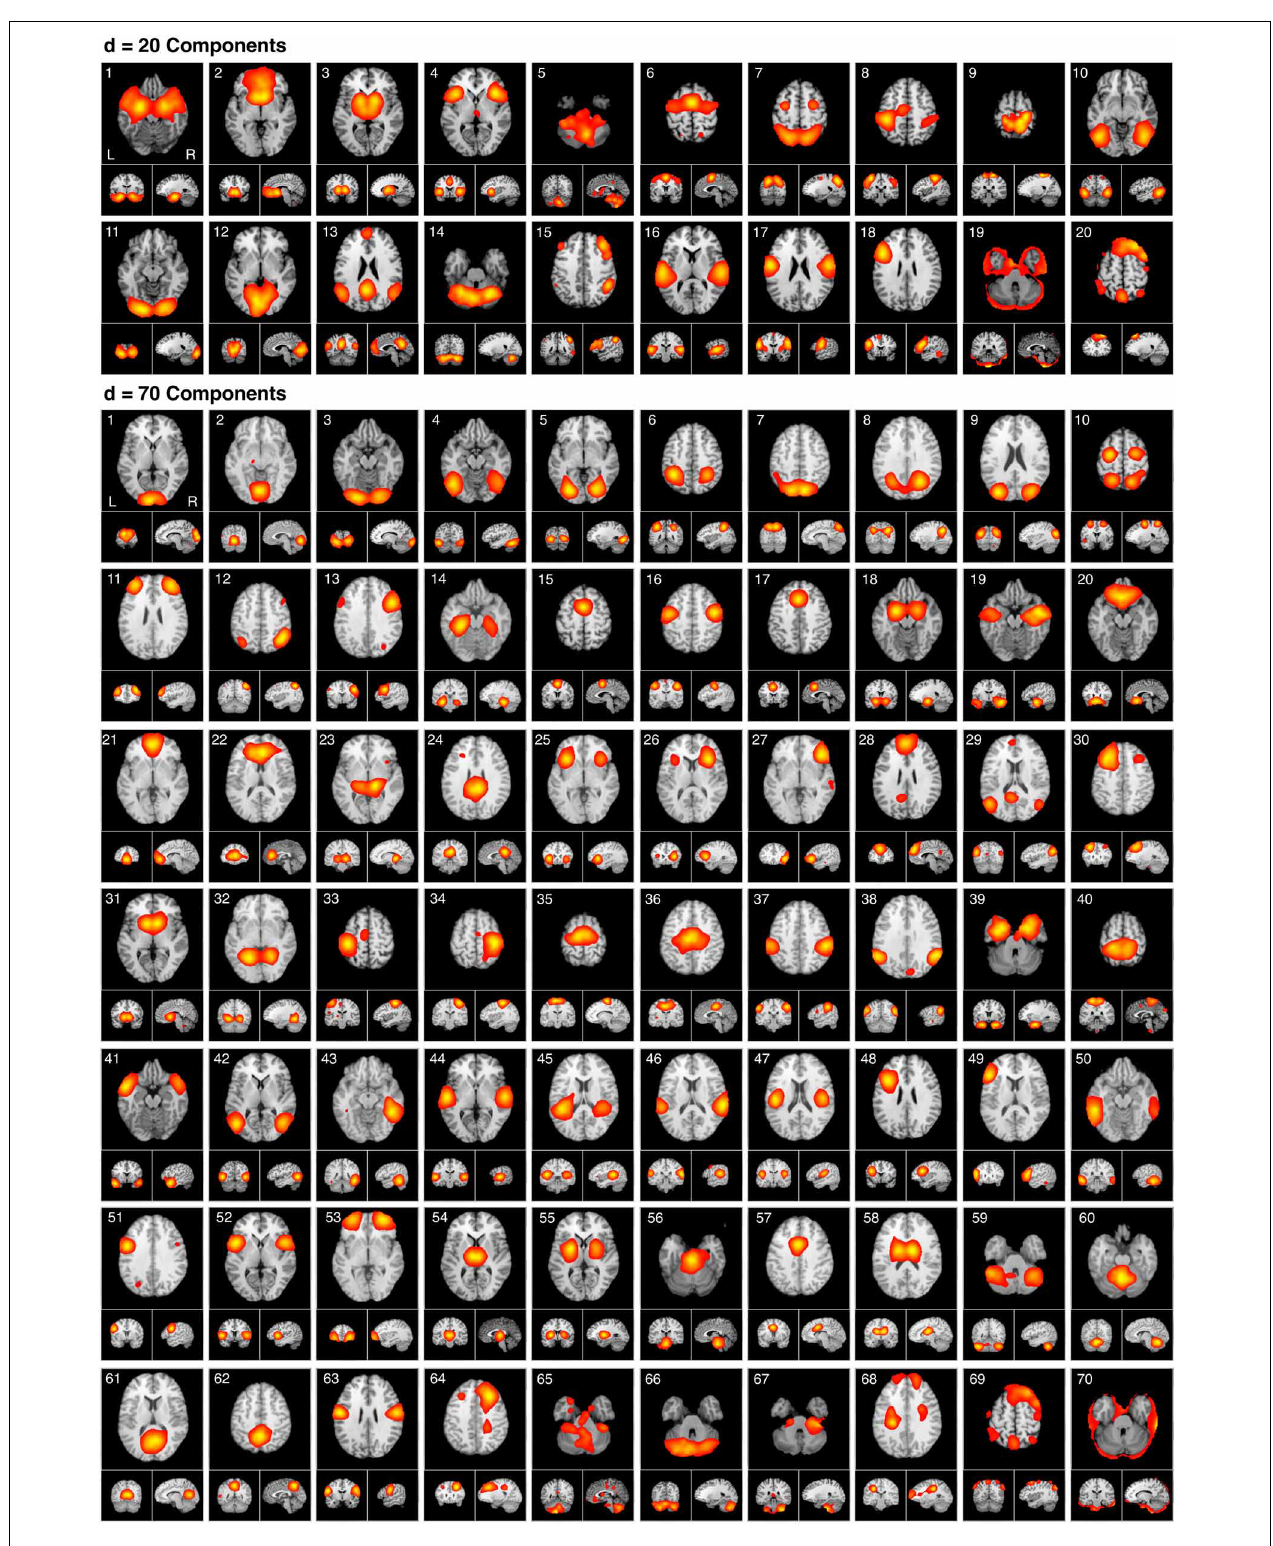
FIGURE 5 | The spatial topography of ICA model orders yielding high quality decompositions identified by producing the highest CC c values at d = 20 and d = 70. The d = 20 components are presented in the same order as provided in Laird et al., 2011a. The d = 70 components mirror the hierarchical network organization of their respective model order, beginning